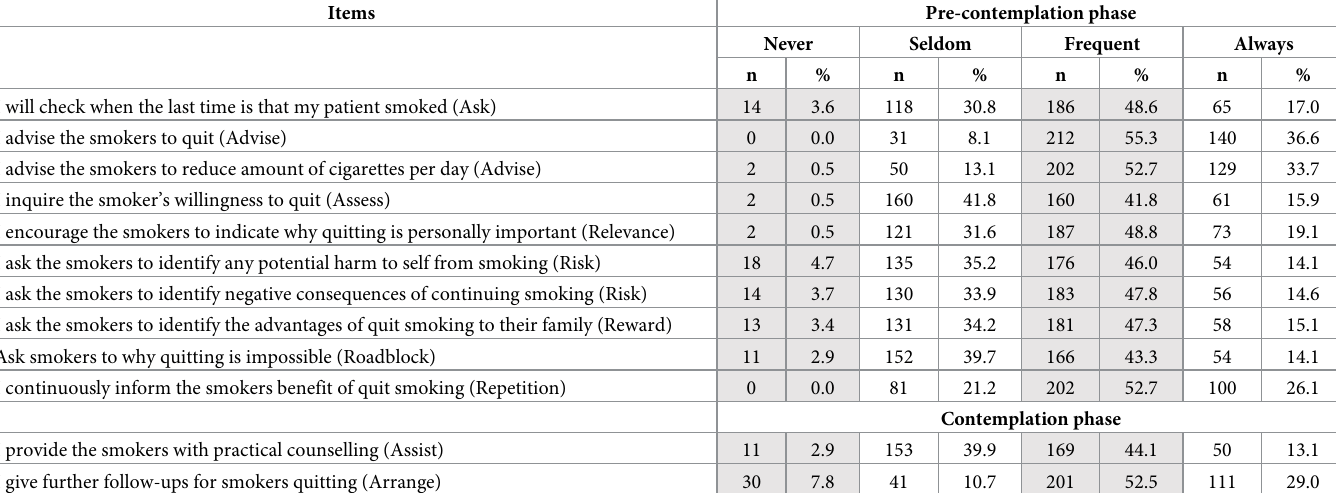
Table 3. The likeliness of practice among primary care doctors for the items of smoking cessation management in the pre-contemplation and contemplation phase.